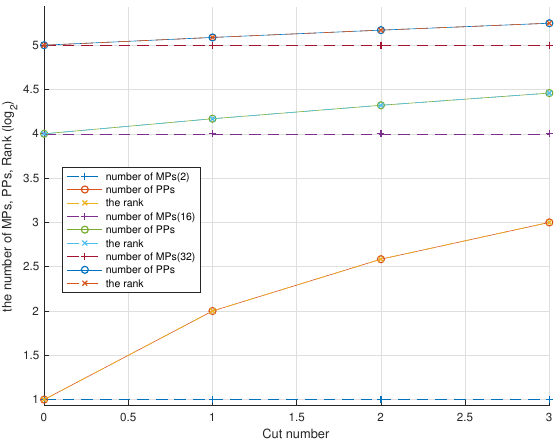
Figure 7. As the number of cuts increases, the number of physical patches is always equal to the rank of the matrix, thus avoiding the problem of linear correlation causing equations that cannot be solved. Using the method in this article, the robustness will be